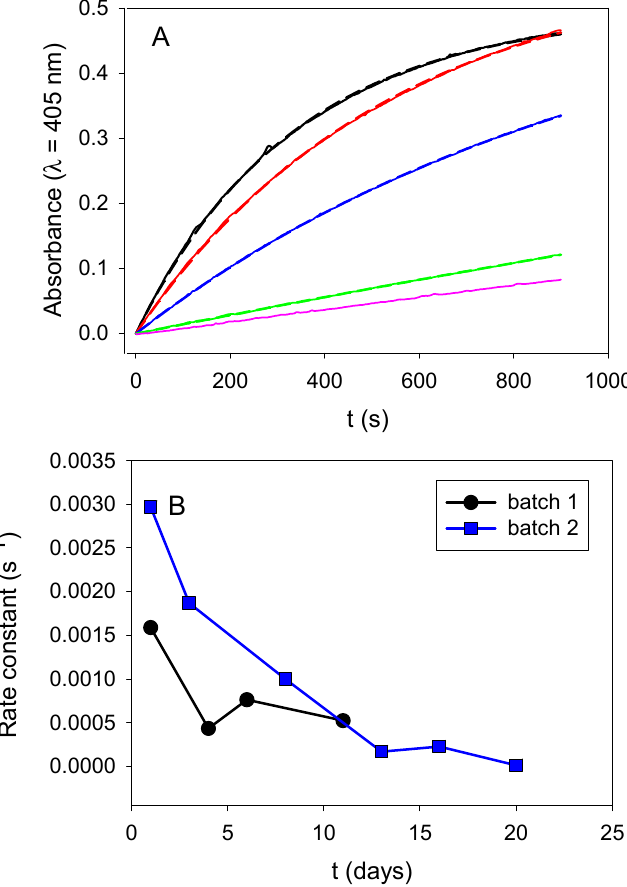
Figure 6. Influence of the substrate concentration and storage time on the enzymatic activity of a 10-fold diluted PDA@ALP nanoparticle suspension. ( A ) Evolution of the enzymatic activity of a 10-fold diluted PDA@ALP nanoparticle suspension in the presence of a 20-fold diluted PNP solution at day 1 (____), 3 (____), 8 (____), 14 (____), and 20 (____) after the end of the particles dialysis step against Tris buffer at pH 8.5. ( B ) Evolution of the rate constant of the enzymatic hydrolysis kinetics shown in ( A ) for a first batch of particles (corresponding to the kinetics displayed in Figure 5A ( (cid:4) )) and for an independent batch of particles ( • ).